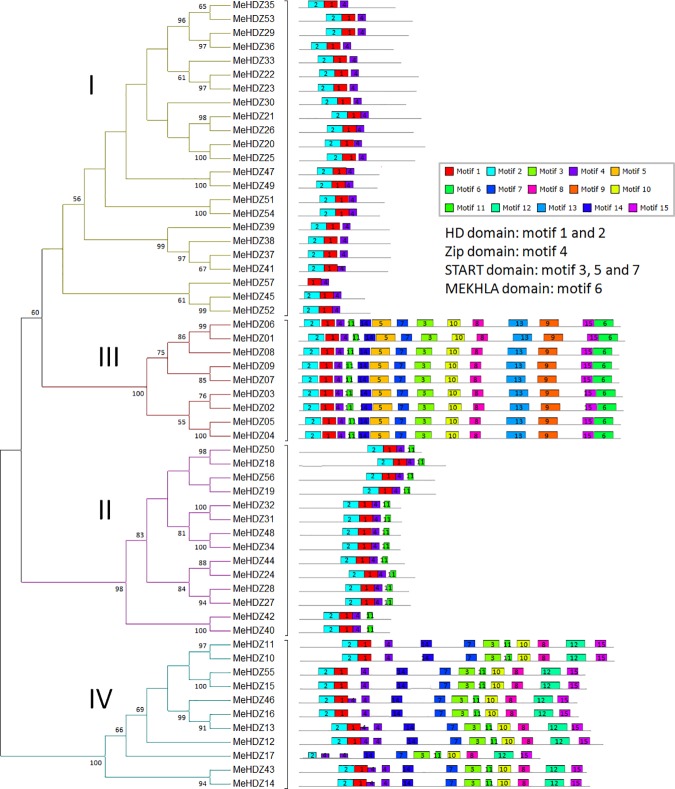
Conserved motifs of MeHDZ proteins corresponding to their phylogenetic relationships.The conserved motifs were identified by MEME software. Motifs were indicated by different colored boxes with the motif number, while non-conserved sequences were represented by grey lines. Length of motifs was exhibited proportionally.